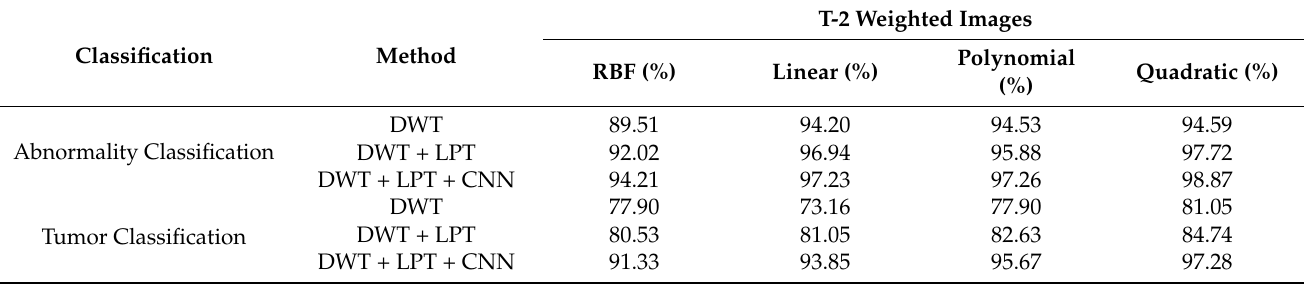
Table 6. Average accuracy for T-2 weighted images.